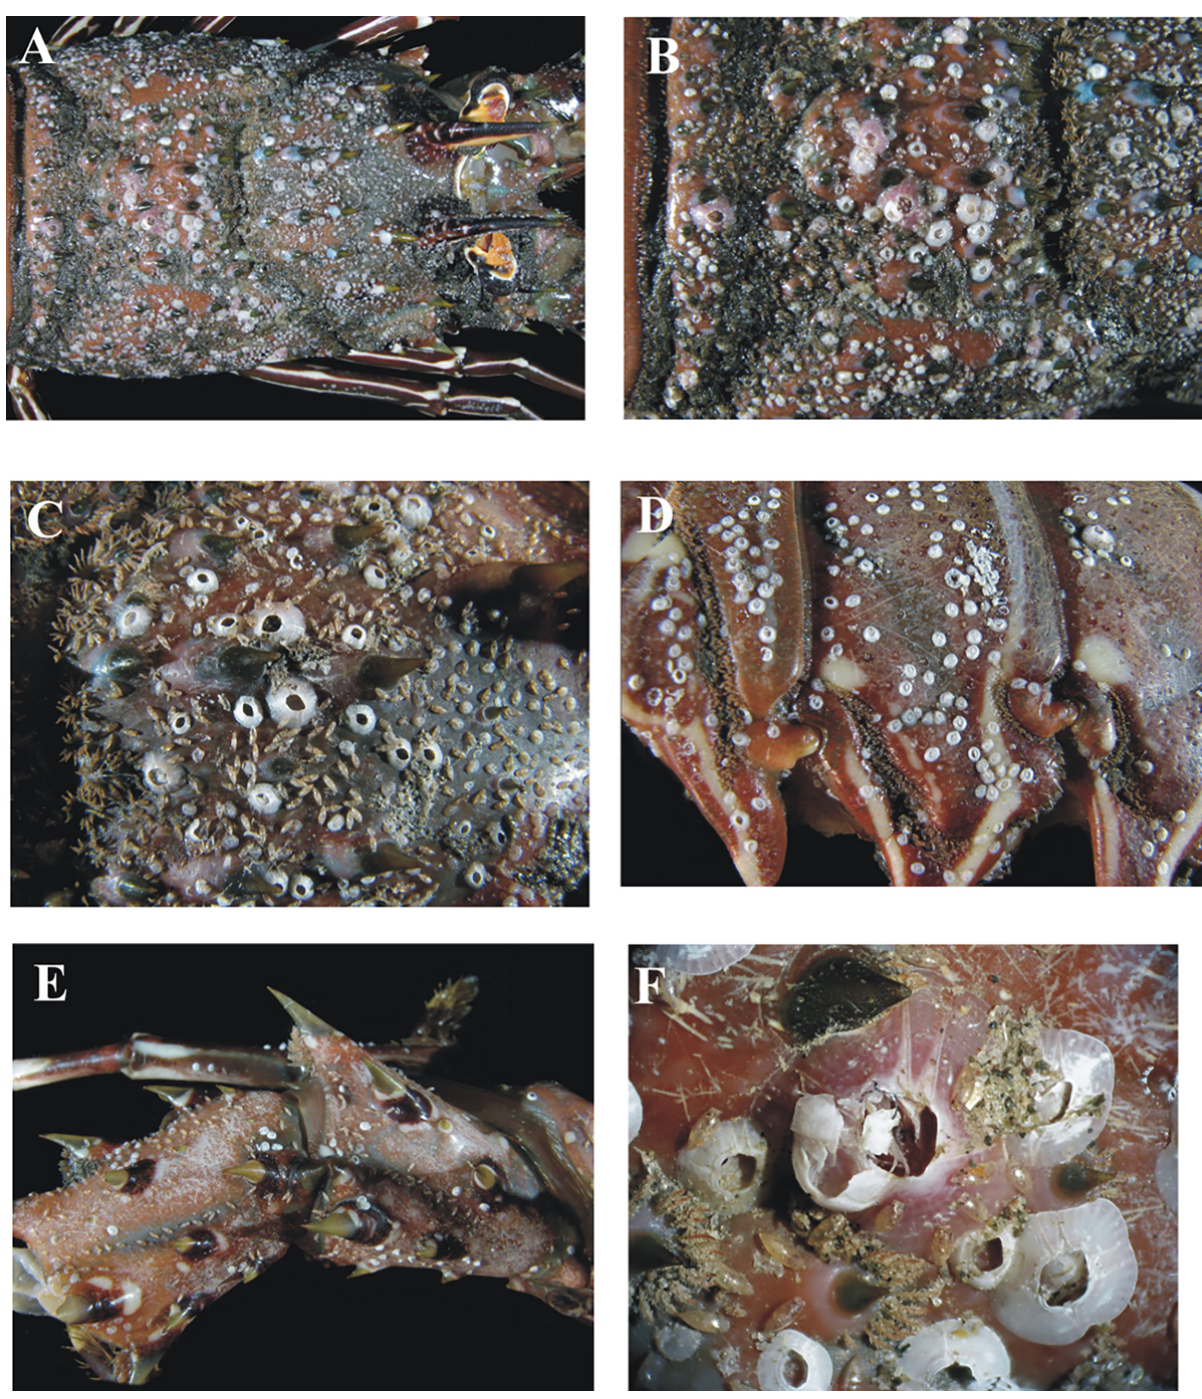
Figure 1. Photographs of selected portions of the carapace and appendages of Panulirus gracilis Streets, 1871, showing accumulation of individuals of Balanus trigonus Darwin, 1854. A. Cephalothorax, dorsal. B. Same, detail of gastric area. C. Same, detail of cardiac area; note the accumulation of the cypris larvae. D. Lateral portion of somites 1‒3. E. Antenna 2; note the settlement pattern of the cypris larvae. F. Detail of carapace showing cypris larvae and encrusting